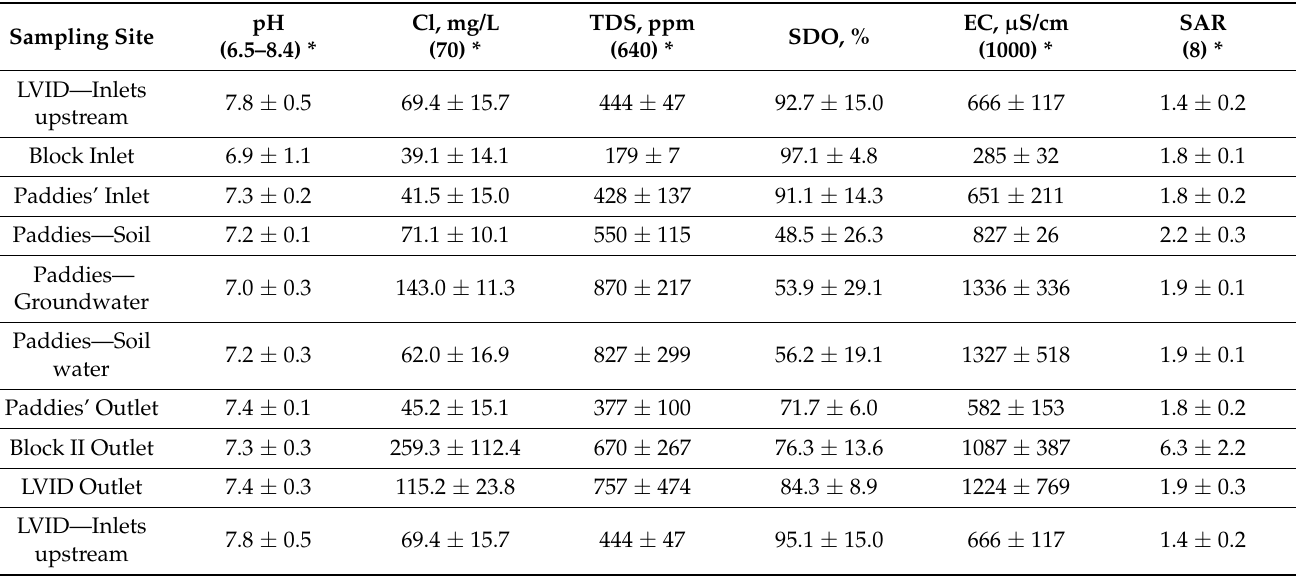
Table 1. Physicochemical parameters of water samples, per sampling site (average ± standard deviation).